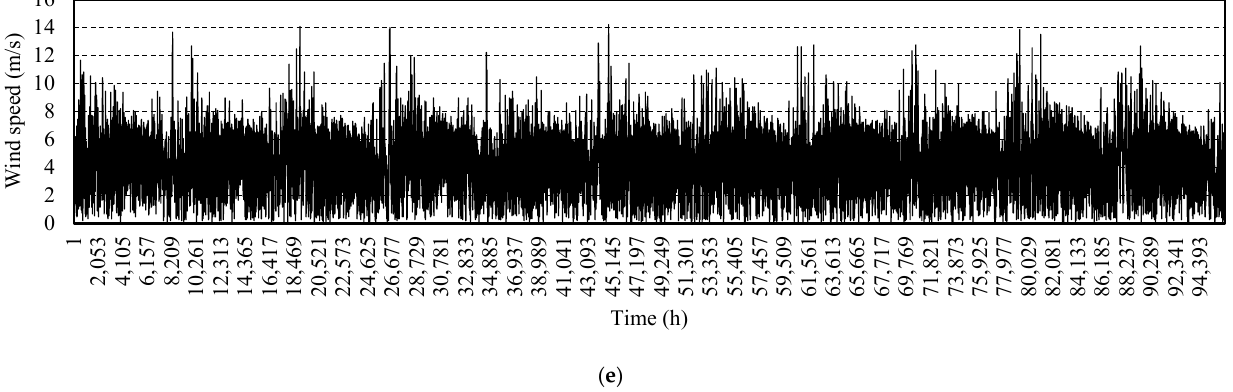
Figure 1. Wind speed data for different sites in the North Coast region of Egypt for 11 years: ( a ) Site 1 located in Sidi Barani, ( b ) Site 2 located in El-Mathany, ( c ) Site 3 located in Ras El-Hekma, ( d ) Site 4 located in El-Galaa, ( e ) Site 5 located in Port Said. Table 2. Results obtained for 10 equal wind speed spacings in the five Egyptian